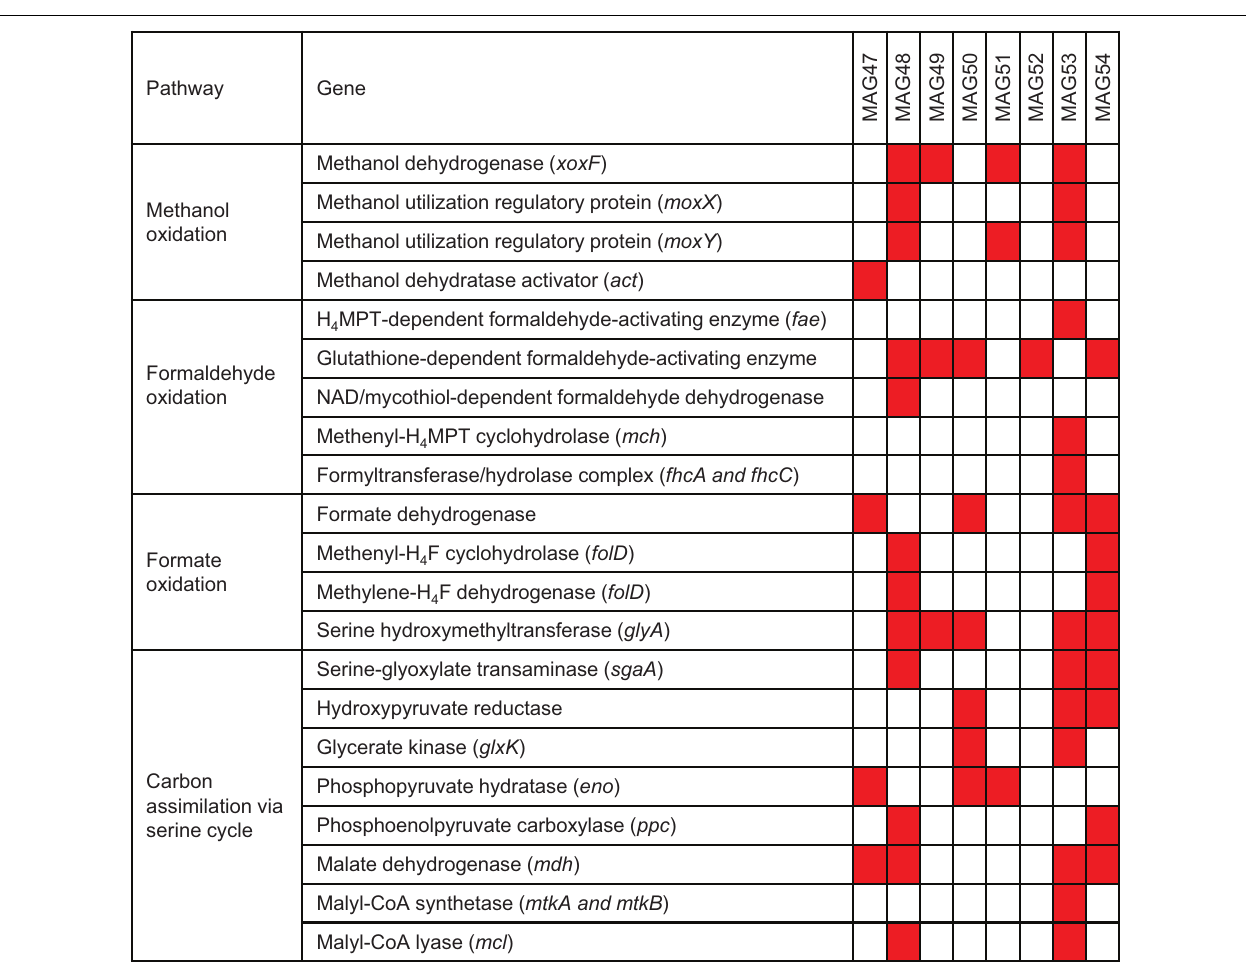
FIGURE 4 | Methylotrophic metabolism in the 13 C-labeled microorganisms from the 13 C-methanol proteomic SIP experiment. 13 C-methanol can be metabolized and assimilated by the eight 13 C-labeled microorganisms through methanol oxidation, formaldehyde oxidation, formate oxidation, and the serine cycle. The red squares mark the presence of the genes involved in these pathways in the eight